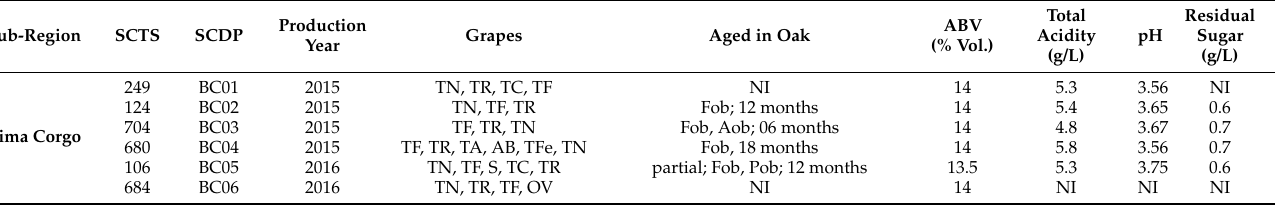
Table 2. List of wines used in the application of the QDA ® and TDS methodologies.